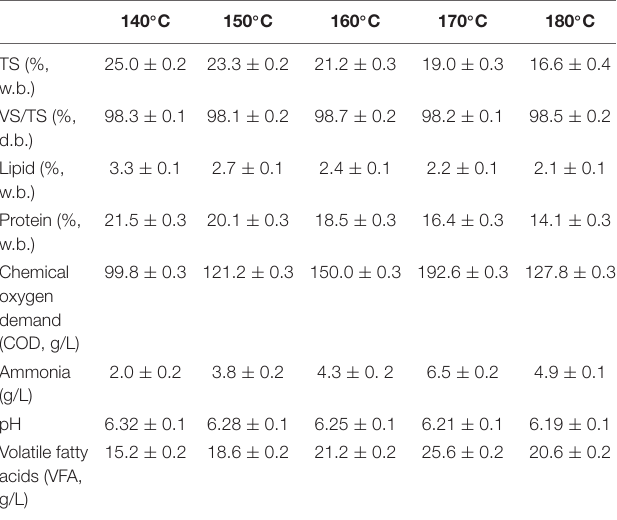
TABLE 3 | Characterization of solid residue (SR) and liquid products (LP) after different hydrothermal pretreatment (HTP)